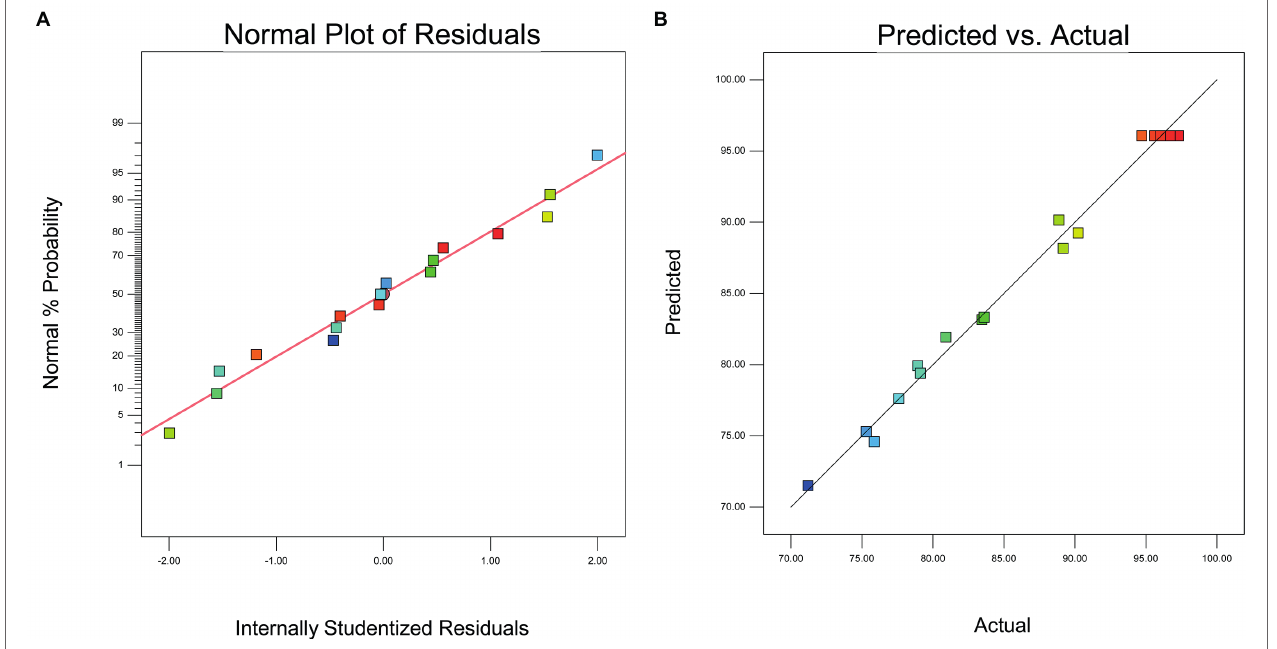
FIGURE 2 | (A) Normal plot of residuals and (B) plot of predicted vs. actual